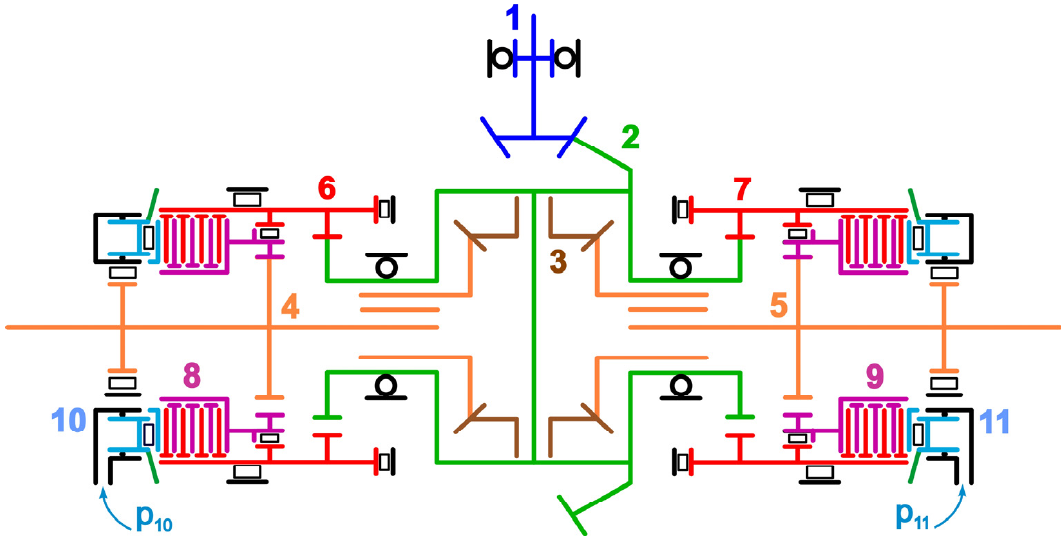
Figure 2. Scheme of Audi Sport Differential.